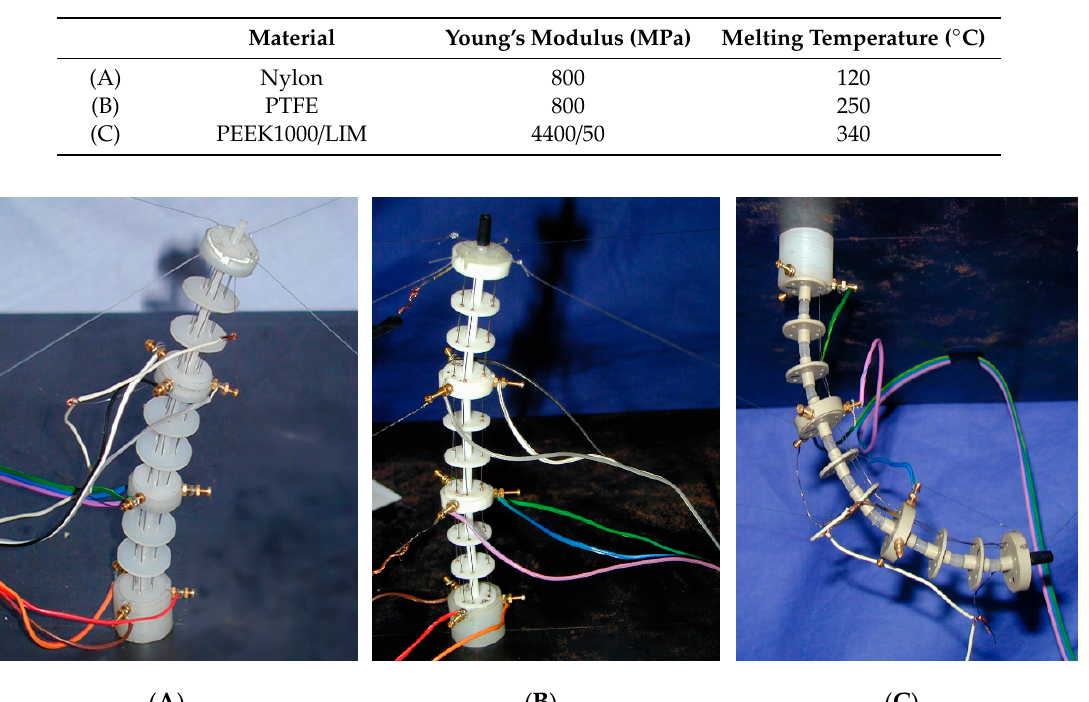
Figure 10. Sketch of the test bench. The test aimed to evaluate the actuator displacement along the three main directions and the three secondary directions (cf. Figure 2) during heating and cooling sequences. The test was carried out with a step supply current of 1 A for the heating phase (duration 30 s). The activation sequence for each direction was the following: activation of the lower module, activation of the central module, activation of the higher module. Cooling was in still air. Each sequence was repeated at least three times. The power supply was 2.8 W. The tests performed on prototype A highlighted its stable and repeatable behavior. The 3D workspace, visible in Figure 11, was sufficiently large. The melting temperature close to the temperatures reached by the SMA wire in the hot phase was an important limit of the prototype, which after a relatively low number of cycles had been damaged in these areas. In a first instance, a local insulation can be added, but design changes have to be implemented.